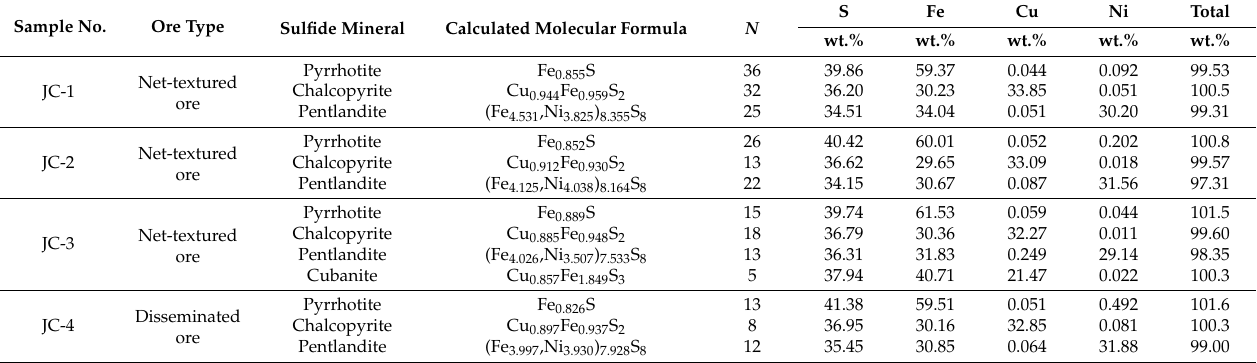
Table 2. Averaged major element content of each sulfide mineral of ore samples in the Jinchuan deposit by EMPA analysis. Sample